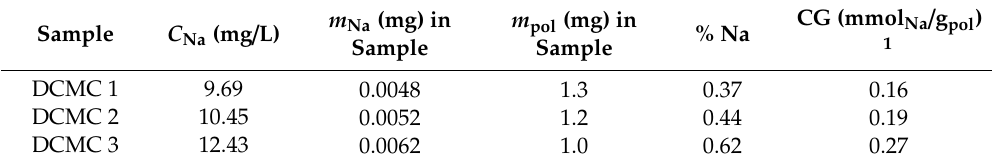
Table 2. Determination of carboxylate groups on polymer samples produced.